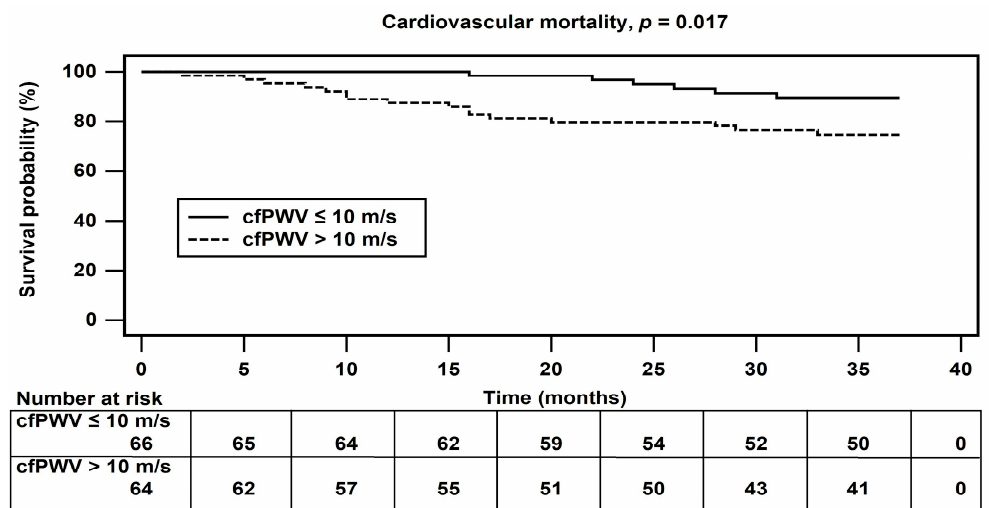
Figure 2. Kaplan–Meier analysis of carotid–femoral pulse wave velocity levels and cardiovascular mortality events in hemodialysis patients.